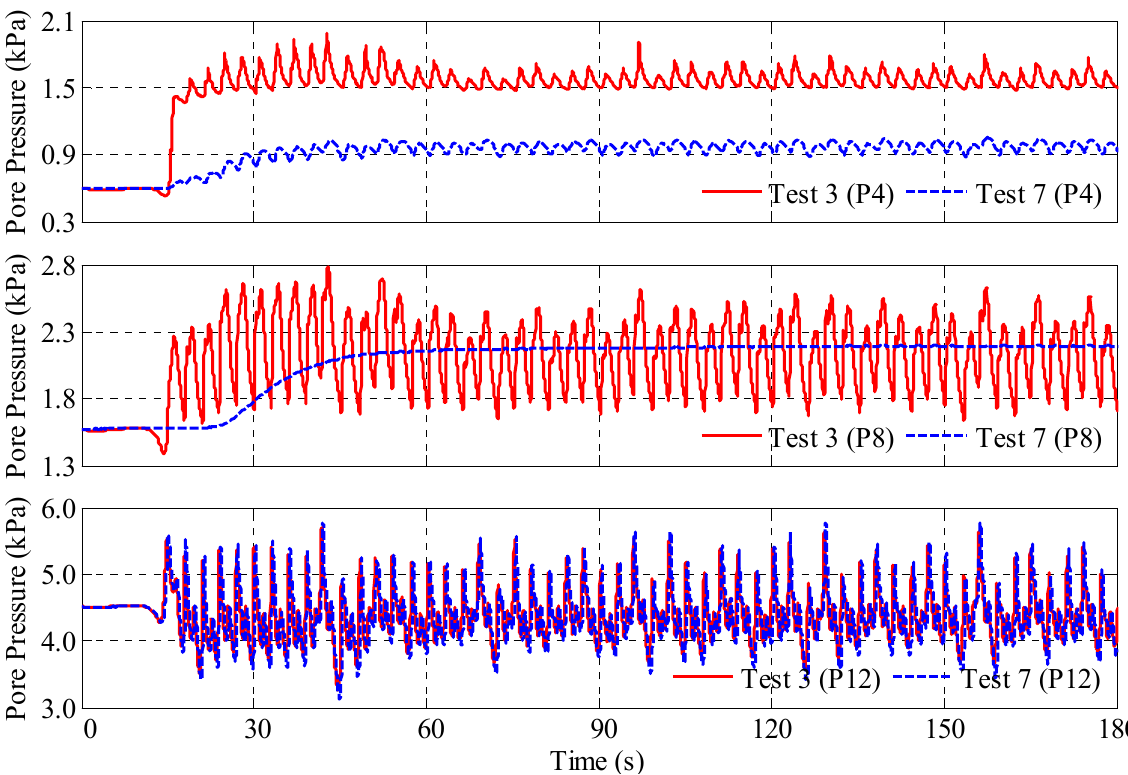
Figure 23. Comparison of pore pressure recorded at P4, P8 and P12 between Test 3 ( ρ d = 1320 kg/m 3 ) and Test 7 ( ρ d = 1500 kg/m 3 ).